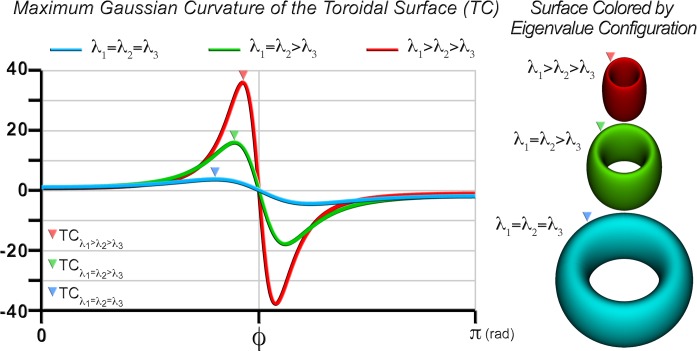
Toroidal curvature (TC) as a function of eigenvalue configuration.Gaussian curvature of the toroidal surface is shown as a function of the polar angle (ϕ) in isotropy (blue), transverse isotropy (green), and anisotropy (red). TC is the maximum of the Gaussian curvature values, as indicated at the positive peaks. The corresponding toroidal surfaces and curvature maxima are shown on the right panel.